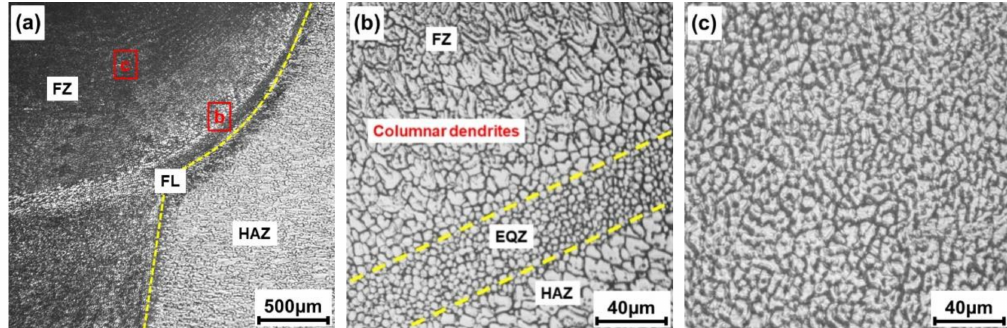
Figure 4. Microstructure of joint transition zone with modification welding: ( a ) low magnification, ( b ) high magnification, and ( c ) the modification welding